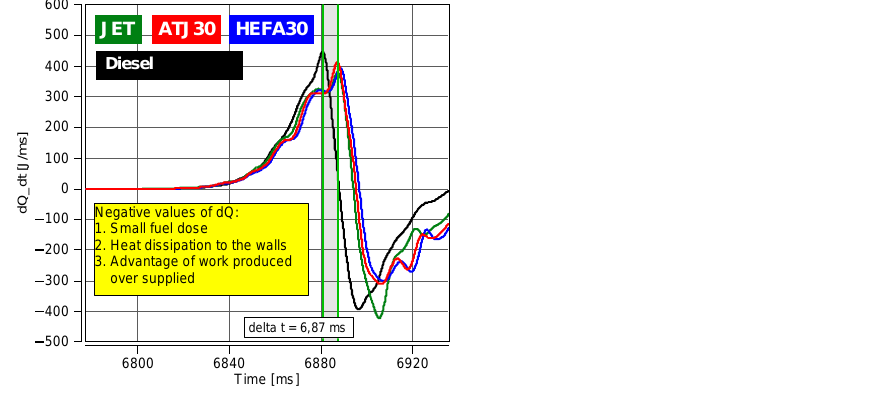
Figure 12. Analysis of the course of heat release during the combustion of the investigated fuels.